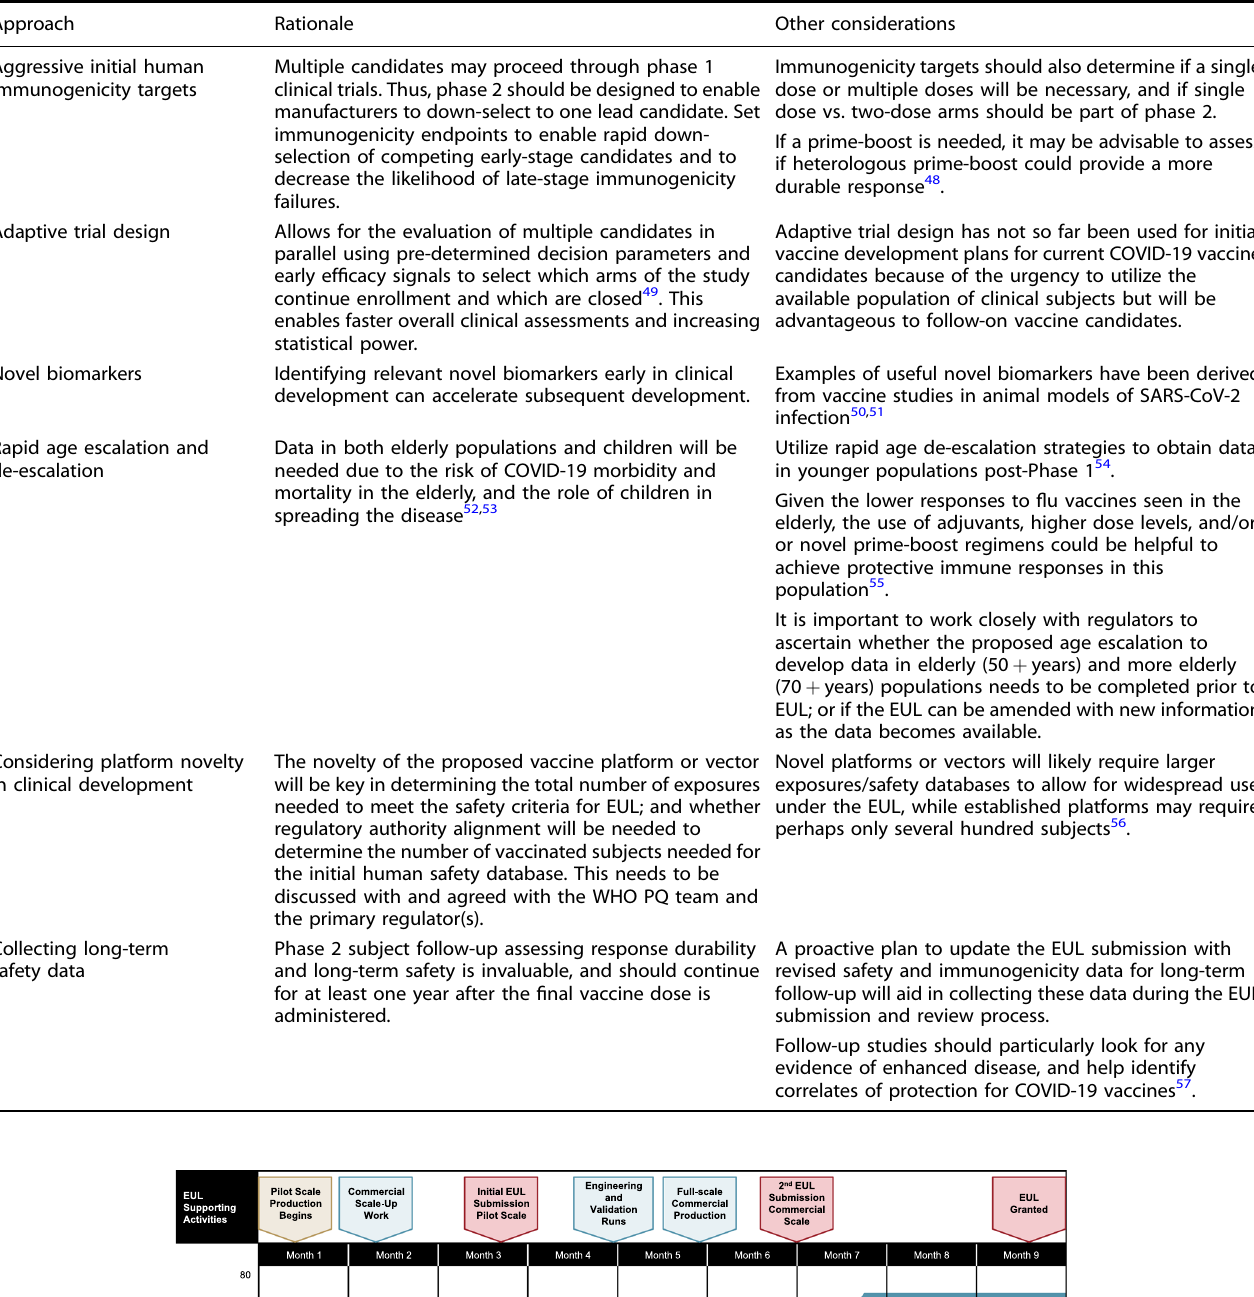
Table 1. Strategies for accelerating clinical